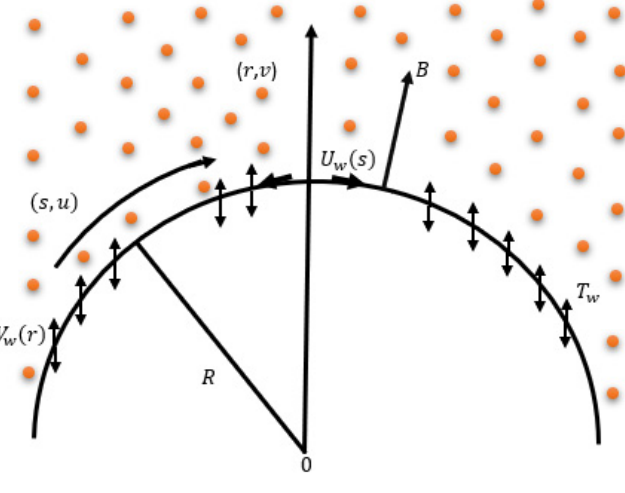
Figure 1. Functional diagram.